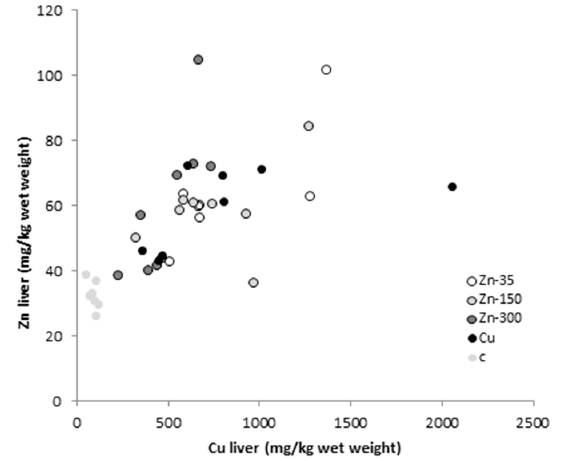
Figure 1. Scatter plot showing the relationship between Cu and Zn concentrations (mg/kg fresh weight) in the liver of sheep at the end of the study, for the five experimental groups: C, control (no treatment); Cu, 450 mg Cu/kg dry matter (DM); Zn ‐ 35, 450 mg Cu + 35 mg Zn/kg DM; Zn ‐ 150, 450 mg